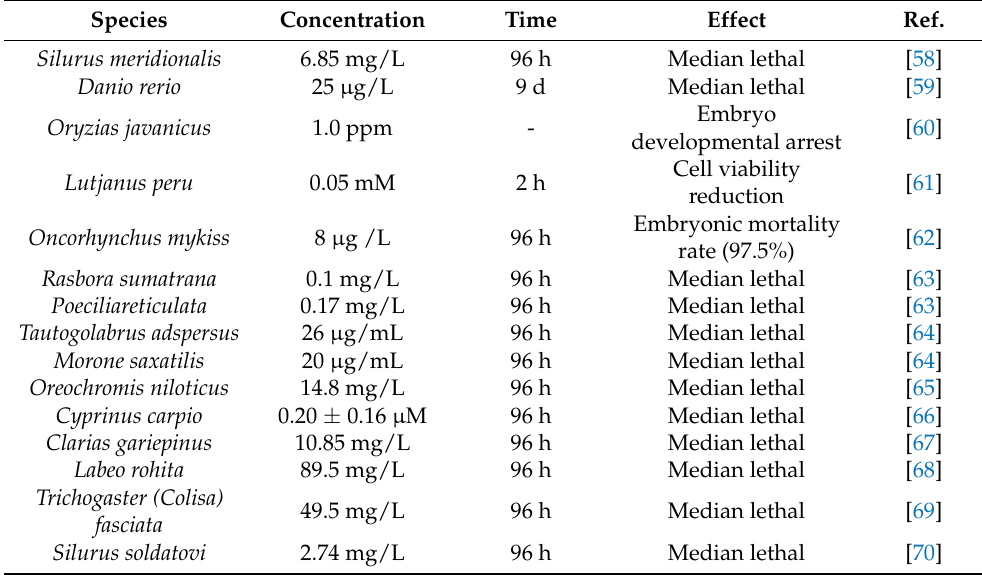
Table 3. Table of lethal effects of cadmium on different fish species. Species Concentration Time Effect Ref. Silurus